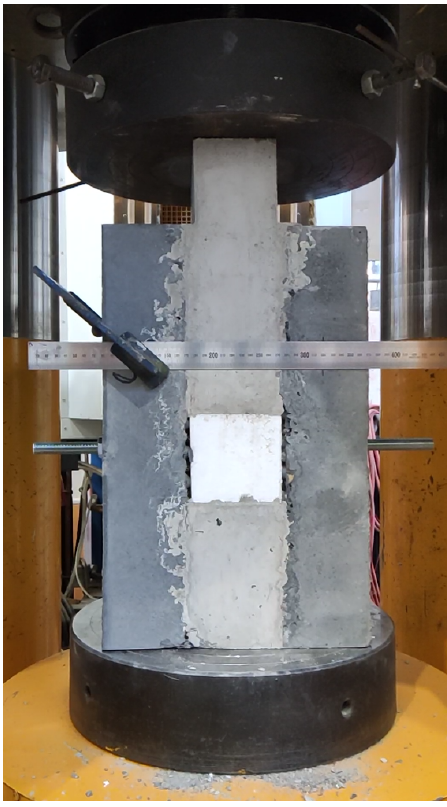
Figure 5. Sandwich sample prepared to be tested in hydraulic loading machine. The gauge is used to determine the formation of the crack.